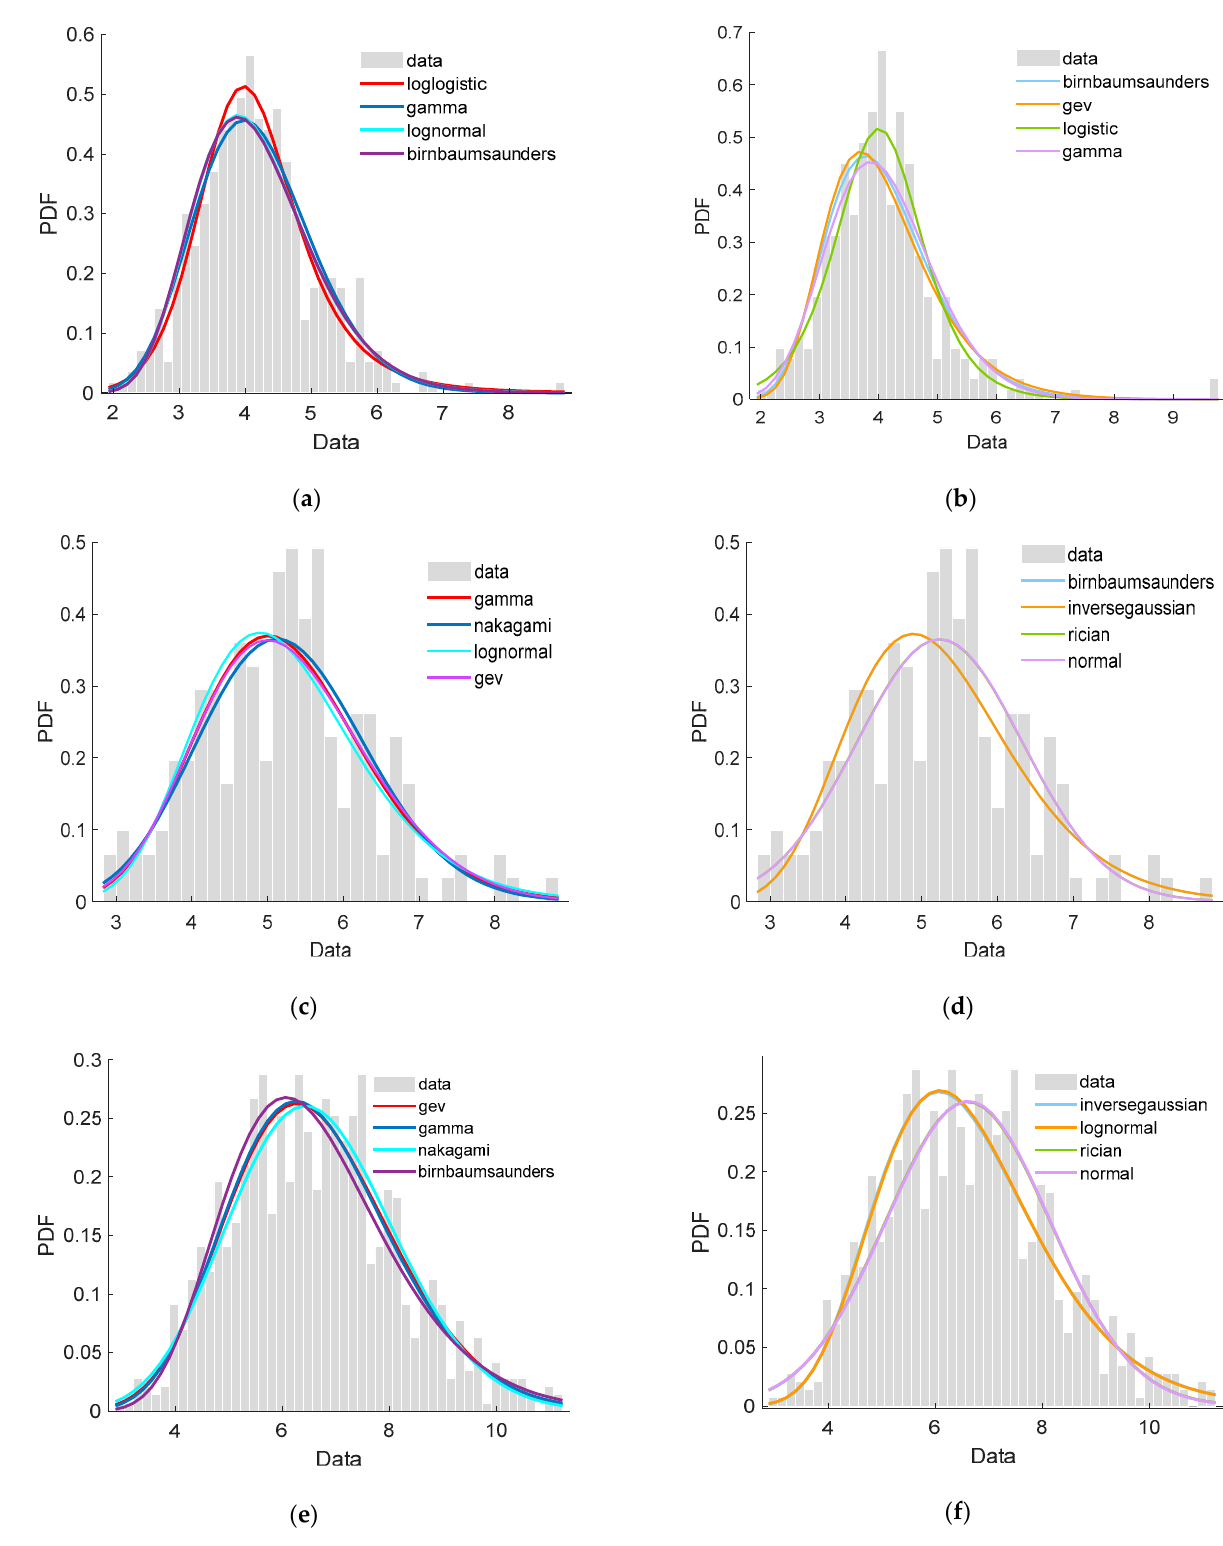
Figure 7. ( a ) Fitting results for models ranked in the 1–4, ( b ) and 5–8 for the Cluster 1; ( c ) Fitting results for models ranked in the 1–4, ( d ) and 5–8 for the Cluster 2; ( e ) Fitting results for models ranked in the 1–4, ( f ) and 5–8 for the Cluster 3.